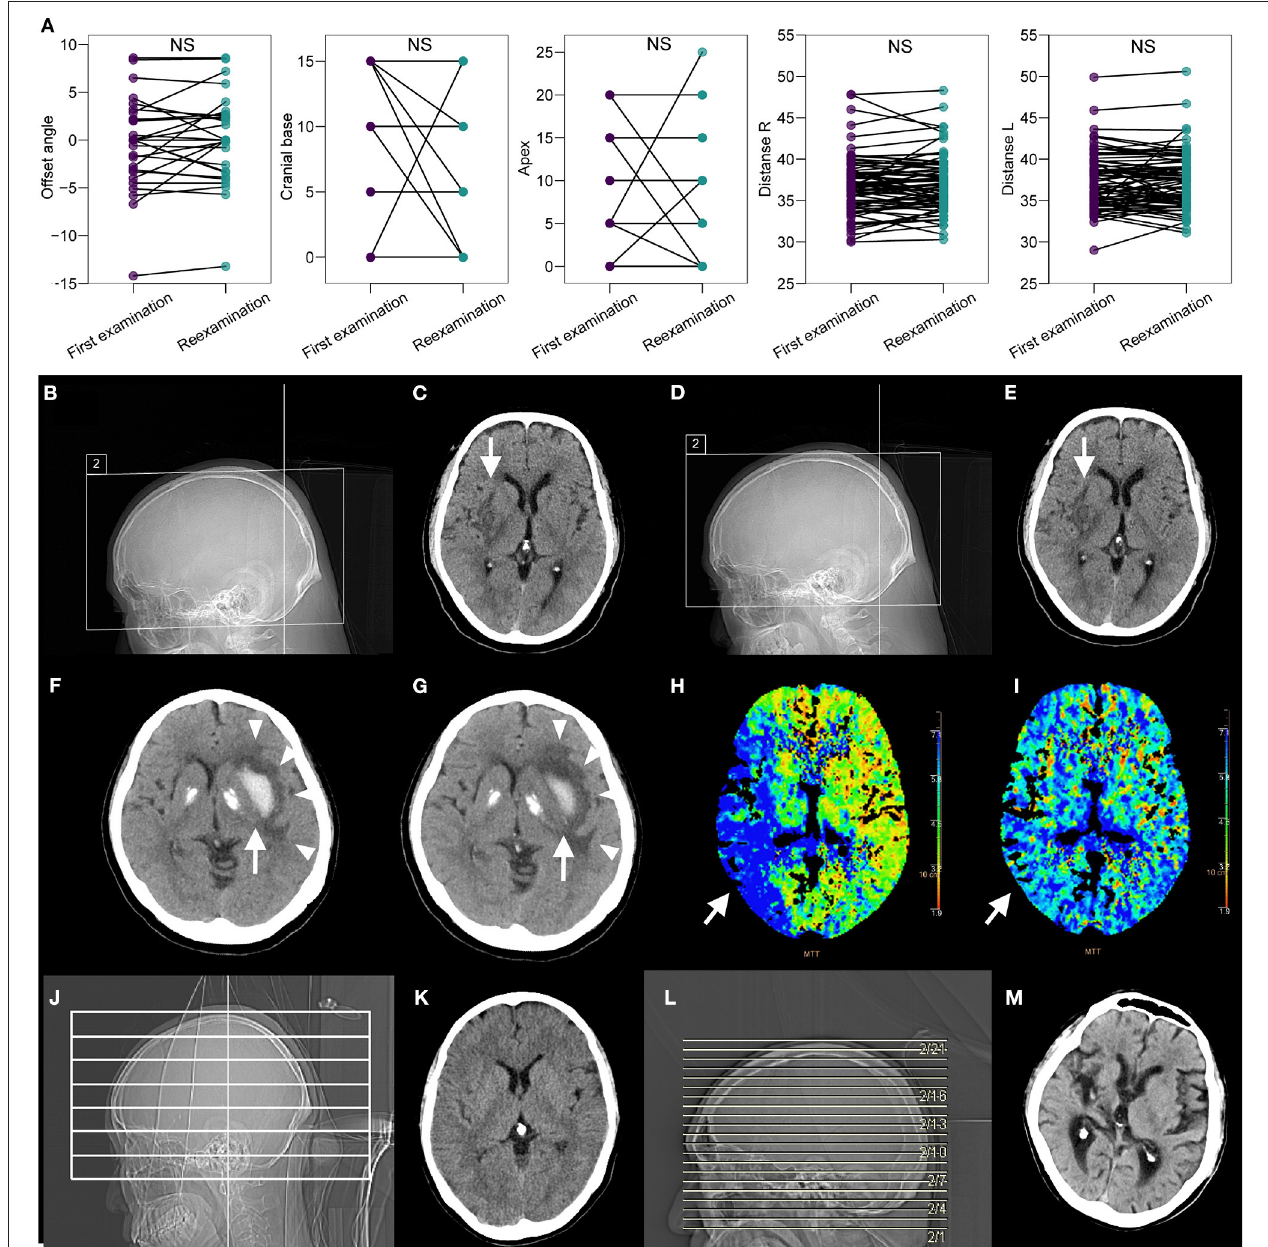
FIGURE 5 | Repeatability of CAPITAL-CT compared with the repeatability of traditional CT. (A) Pairwise comparison revealed no significant difference between the first examination session and the reexamination session regarding offset angle, apex edge, cranial base edge, distance from both lateral ventricles to the intracranial plate, and the distance between bilateral ventricles (all paired t -test P > 0.05 and labels as ns for non-significance) for images collected from a total of 77 patients who required reexamination. (B–E) The patient diagnosed with ischemic cerebral infarction in the right basal ganglia (white arrow) has an ASPECTS score of 7 points. The score was reassessed as 7 points upon reexamination because the images obtained from the first examination and reexamination almost completely overlapped. (F,G) In the patient with cerebral infarction in the area dominated by the right middle cerebral artery (white arrow), the comparison of the mean transit time (MTT) images before and after thrombus recanalization showed that the levels were consistent, and the MTT before and after the thrombus had obvious improvement in blood flow. (H,I) For the patient with hemorrhagic stroke in the left basal ganglia area, the white hematoma (white arrow) was found to be significantly reduced, but the surrounding edema (white triangles) did not change after a few days of reexamination, and the images of the two sequences completely overlapped. (J–M) Compared with other traditional CT imaging results, CAPITAL-CT-derived images are highly reproducible.